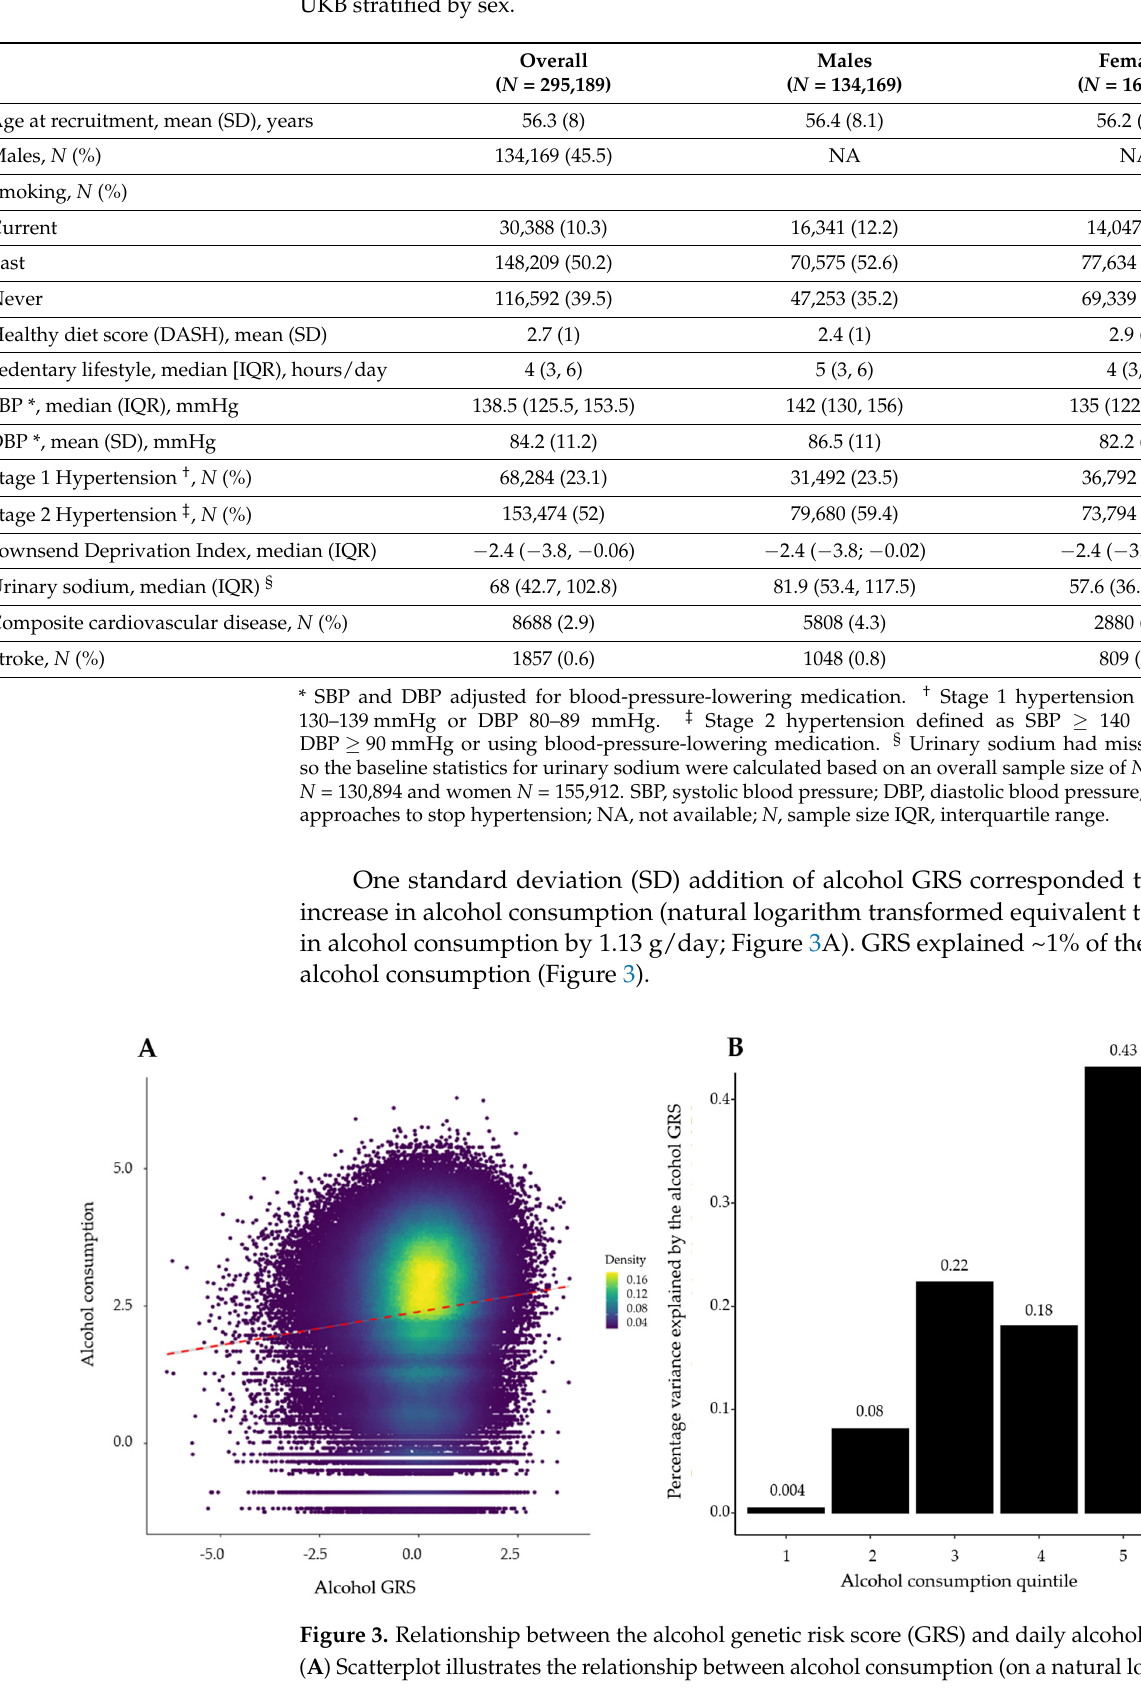
Table 1. Baseline characteristics and incident events of cardiovascular diseases for participants of the UKB stratified by sex.